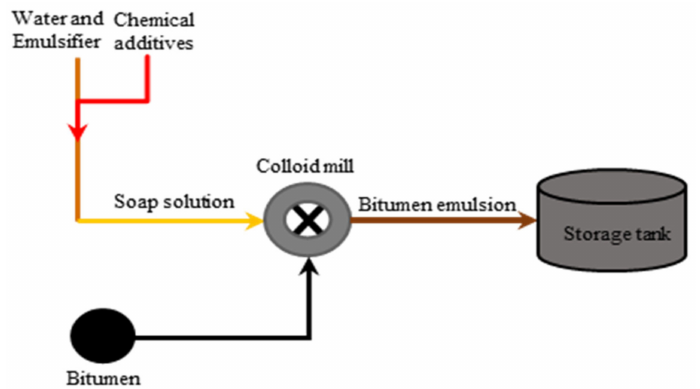
Figure 8. Colloid mill cross section adapted from [110].